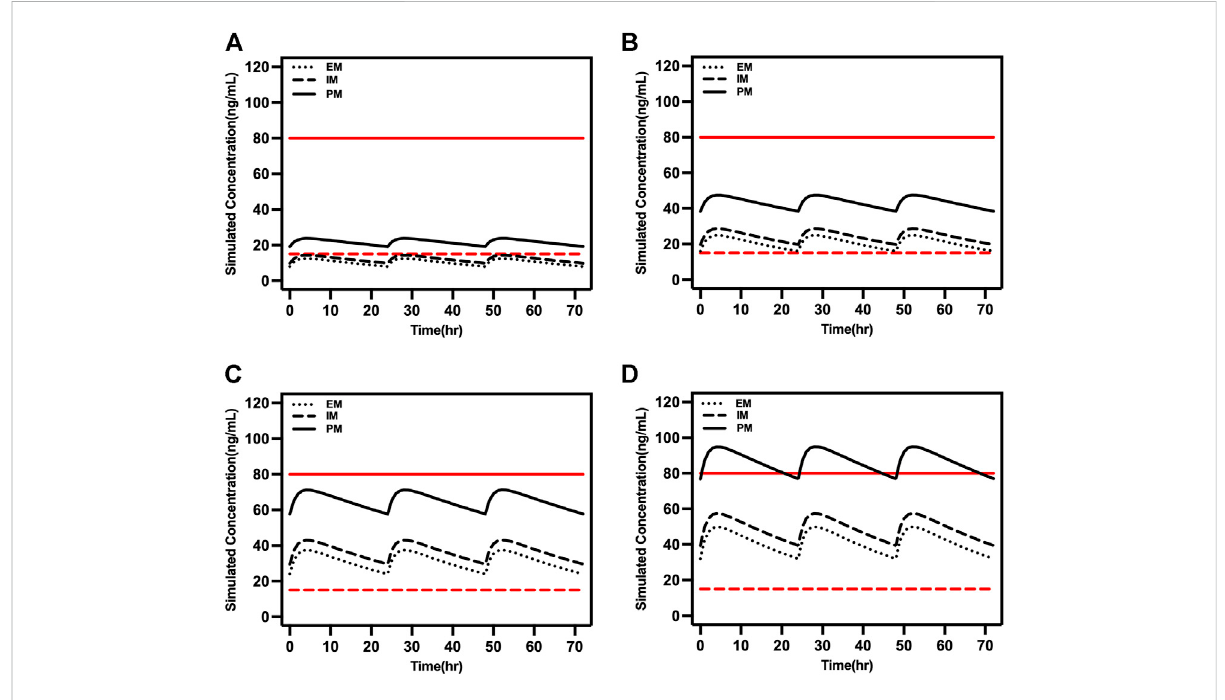
FIGURE 6 Simulated concentrations in EM, IM, and PM adolescents (16 years old) at (A) 5 mg/day, (B) 10 mg/day, (C) 15 mg/day, and (D) 20 mg/day. The red dash lines represented 15 ng/ml and the red solid lines represented 80